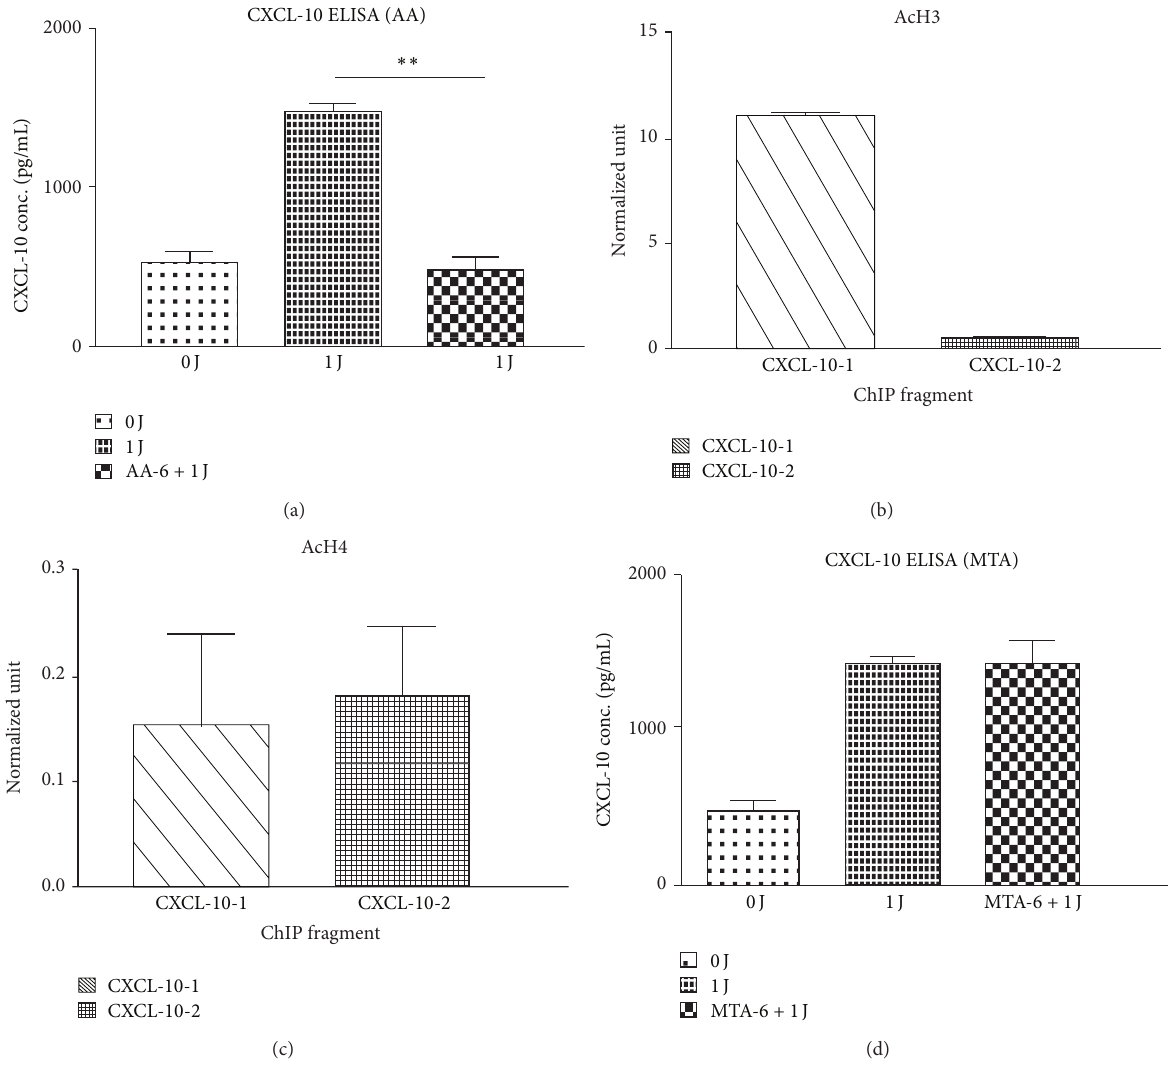
Figure 7: LLLT-induced IP-10 expression in human monocytes via inhibiting histone acetylation, but not trimethylation. The levels of IP-10 expression in LLLT-treated THP-1 cells in the presence or absence of AA (a) and MTA (d) using ELISA assay. ChIP analyses of the relative levels of (b) acetylated H3 (AcH3) and (c) acetylated H4 (AcH4) at the IP-10 gene locus encompassing the following subregions relative to